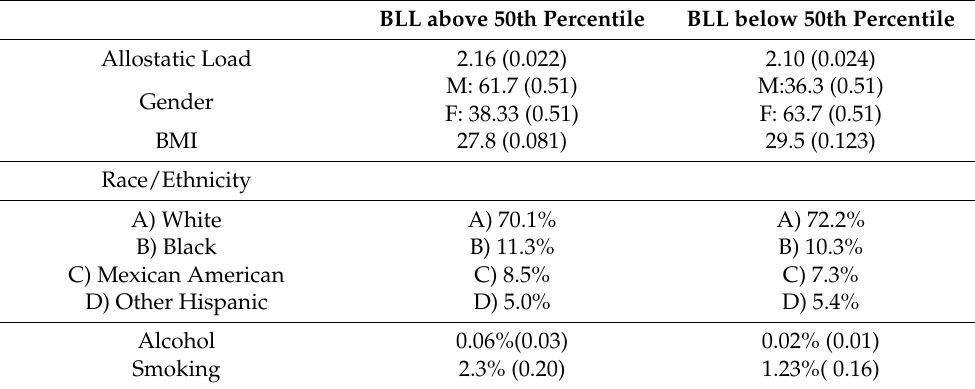
Table 1. Means (stderr) and prevalence of analysis variables across BLL levels above and below the 50th percentile in US population.